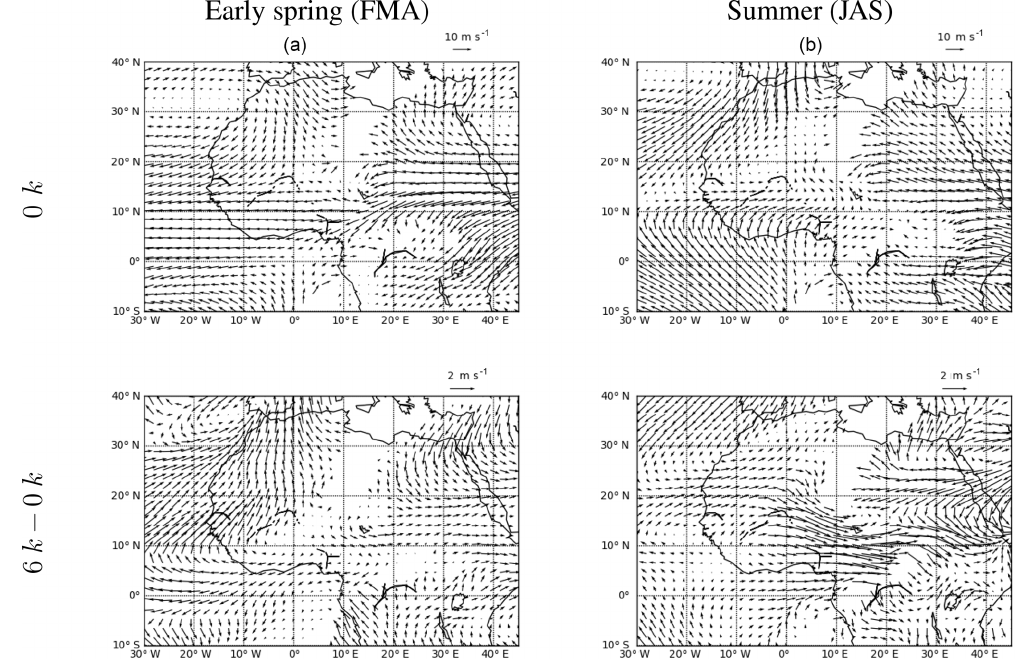
Figure 11. Simulated 925hPa wind speed and directions for early spring (FMA, a , c ) and summer (JAS, b , d ) for 0k and for the difference between 6 and 0k.